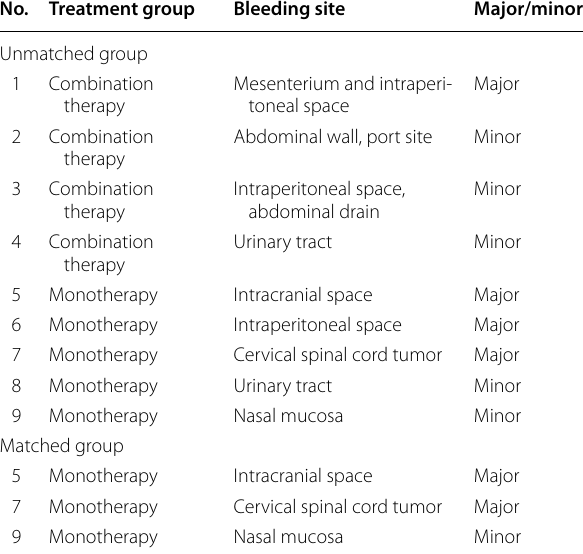
Table 4 Bleeding